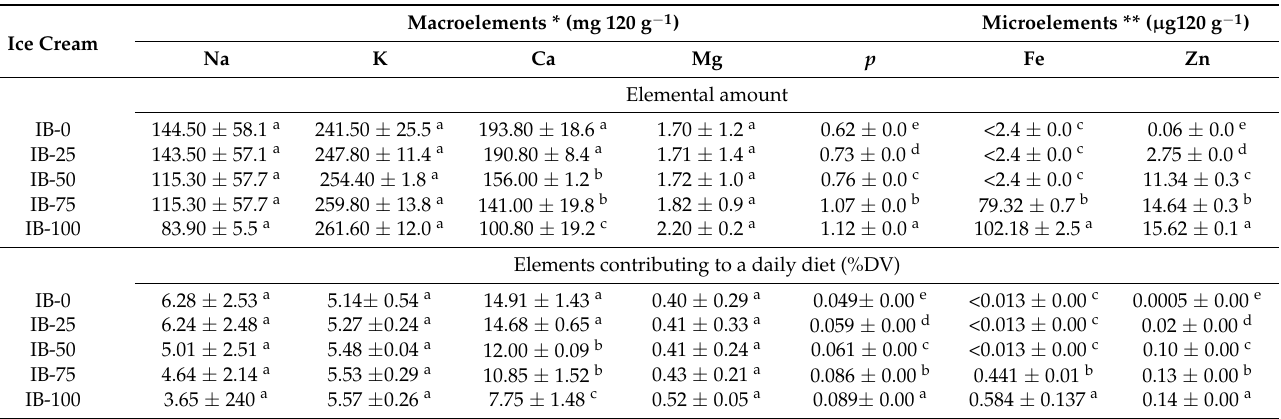
Table 4. Macro- and microelements in different samples represented as amounts per one ice cream serving (120